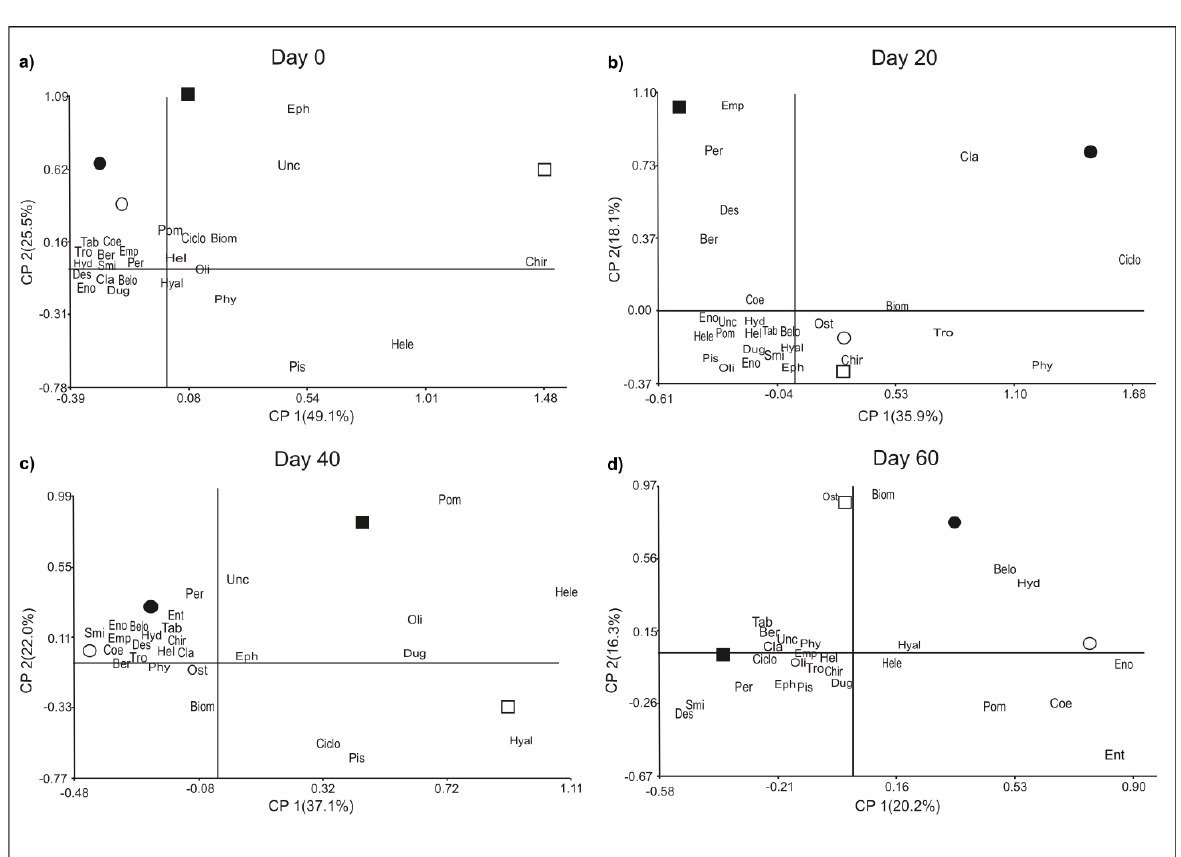
Figure 5. Principal Coordinate Analysis (PCoA) for each day showing the spatial ordination of the two sites (ES: circle and TS: square) and both macrophytes ( H. nymphoides : black, S. pectinata: white) in relation to their macroinvertebrate abundance. a) Day 0; b) Day 20; c) Day 40; d) Day 60. Oli: Oligochaeta; Ent: Entomobryidae;